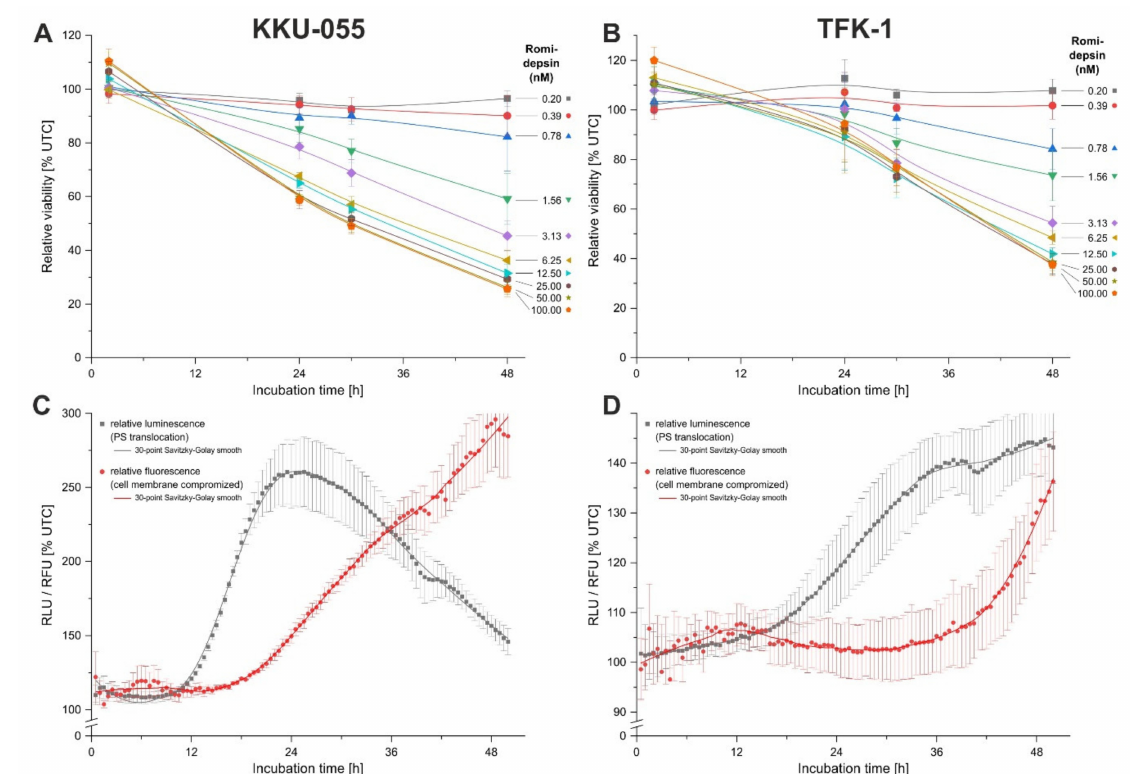
Figure 4. Romidepsin induces apoptosis in BTC cells. ( A , B ) Time-resolved analysis of cytotoxicity of romidepsin via resazurin-based endpoint measurement of cell viability in and KKU-055 ( A ) and TFK-1 cells ( B ) indicates direct time- and dose-dependent cytotoxicity. ( C , D ) Non-endpoint, continuous measurement of PS translocation and membrane integrity under cell incubator conditions (5% CO 2 , 37 ◦ C, humidity) reveals apoptosis and secondary necrosis in KKU-055 ( C ) and TFK-1 ( D ) cells, respectively. Data are presented as mean value ± SEM related to untreated control cells of n = 4 individual biological replicates. Abbreviations: BTC, biliary tract cancer; PS,